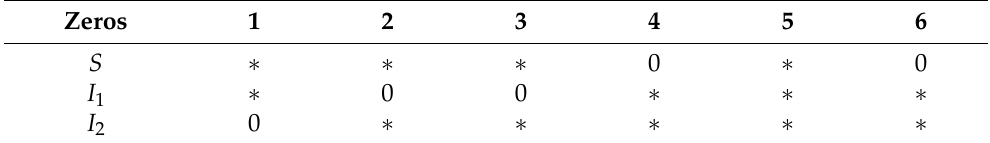
Table 2. Zeros of (8): each column corresponds to a zero.